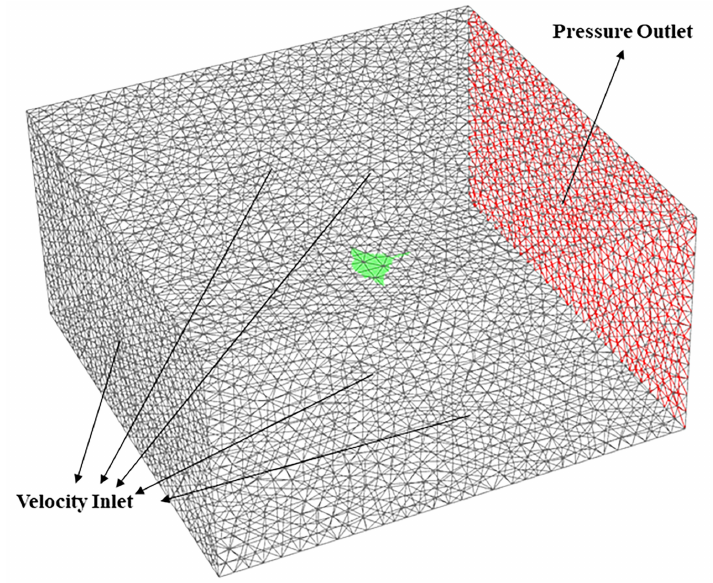
Figure 10. Computational domain of the manta ray robot.